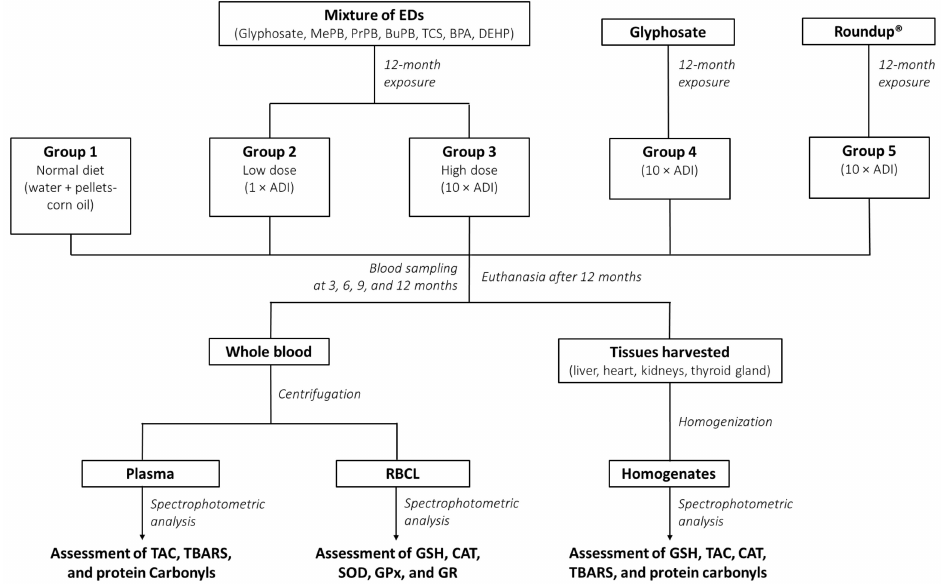
Figure 1. The study design. EDs: Endocrine disruptors; MePB: Methylparaben; PrPB: Propylparaben; BuPB: Butylparaben; TCS: Triclosan; BPA: Bisphenol A; DEHP: di-(2-ethylhexyl) phthalate; ADI: Acceptable daily intake; RBCL: Red blood cell lysate; GSH: Reduced form of glutathione; TAC: Total antioxidant capacity; CAT: Catalase; SOD: Superoxide dismutase; GPx: Glutathione peroxidase; GR: Glutathione reductase; TBARS: Thiobarbituric acid reactive